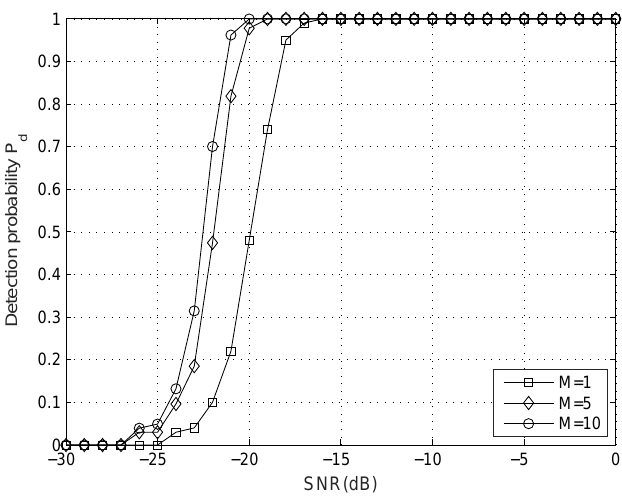
Figure 6. Detection probability comparison of different numbers of secondary users